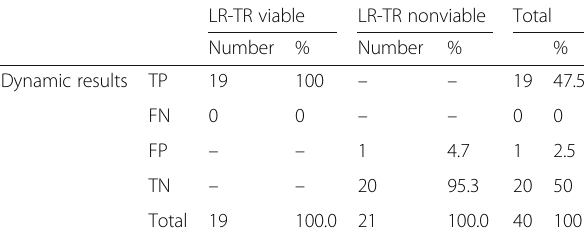
Table 3 Correlating DCE MRI results to the final diagnosis in the studied group LR-TR